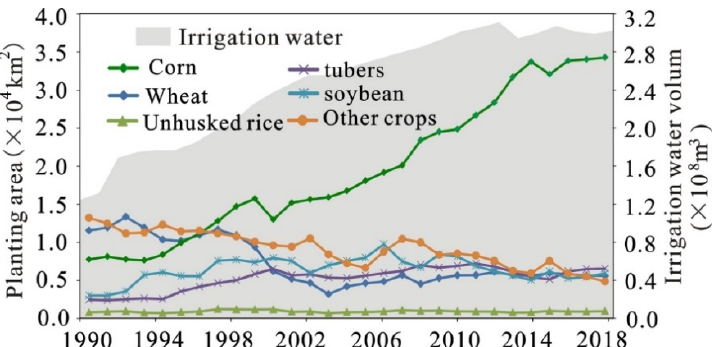
Figure 7. The changes of crop planting structure and irrigation water area in Inner Mongolia from 1990 to 2018.